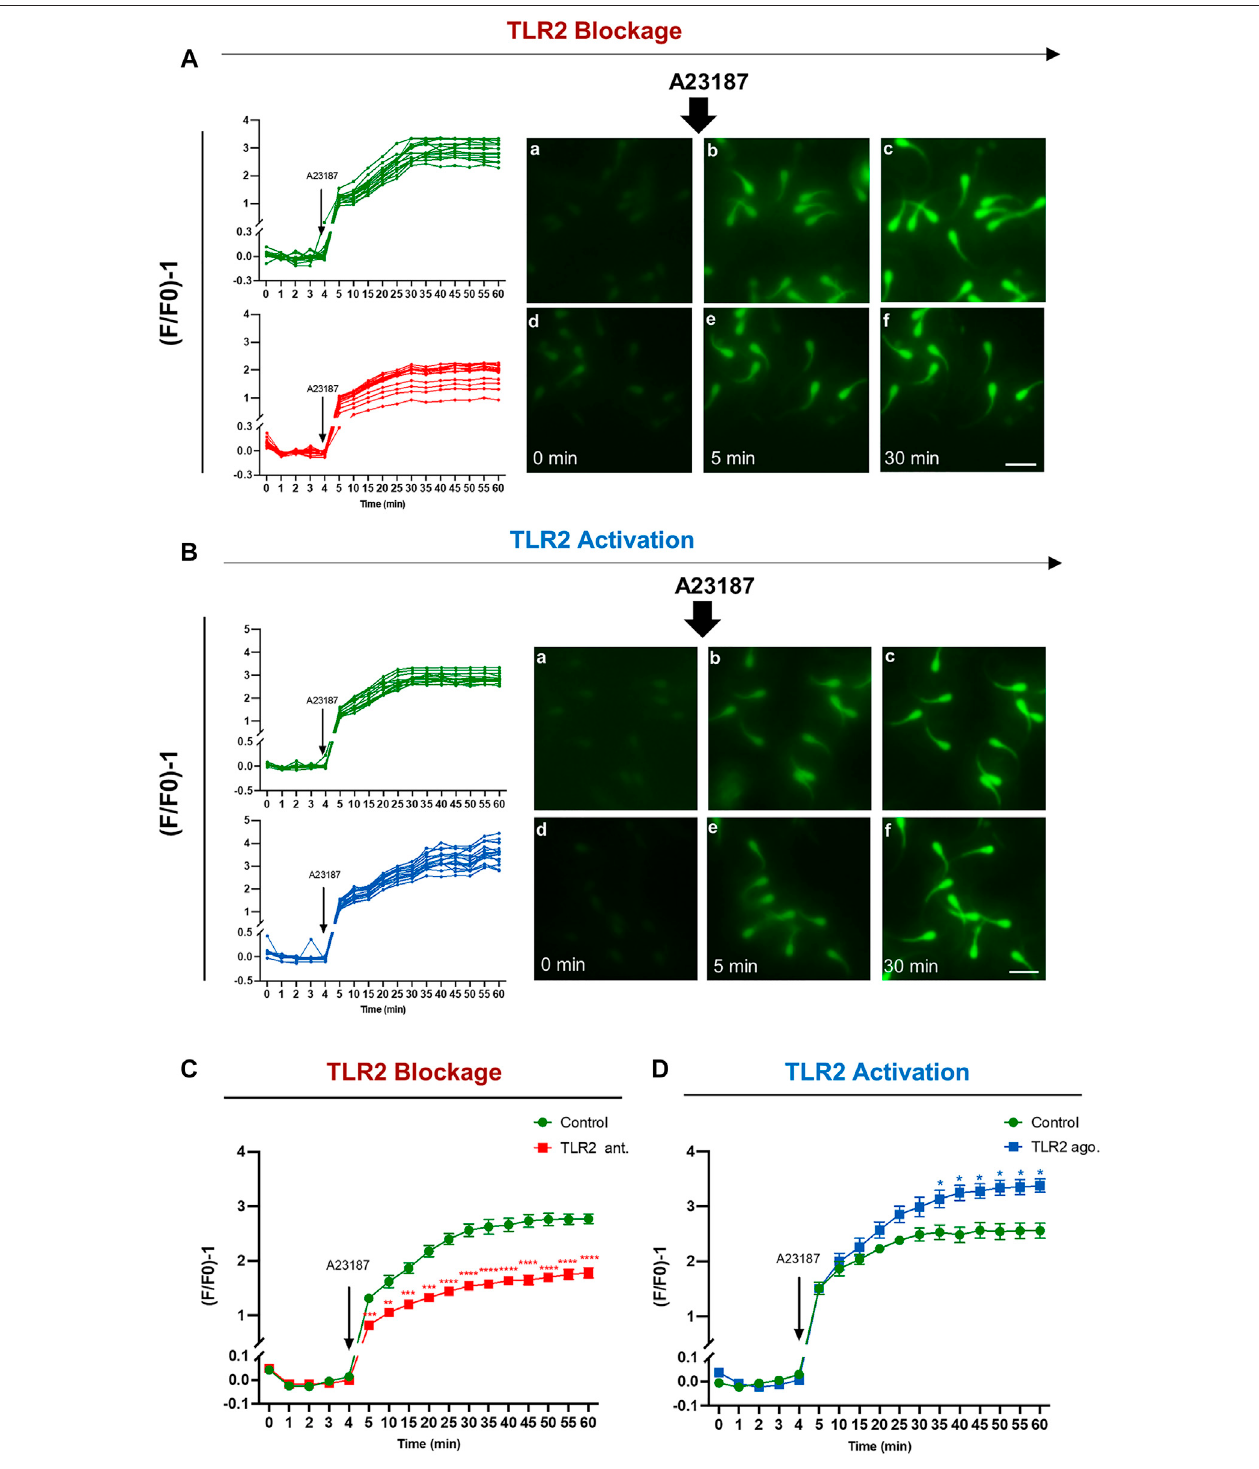
FIGURE 7 | TLR2 system manipulates the intracellular calcium uptake by bovine sperm. Swim-up sperm were pre-treated by TLR2 antagonist (100 µM) or TLR2 agonist (100 ng ml − 1 ) for 30 min, washed, and loaded with 5 µM Fluo-4 AM for 40 min at 38.5 ° C in the dark before adding calcium ionophore A23187 (1 µM as a fi nal concentration). The sperm fl uorescence was measured by the fl uorescence microscope. Images were captured every 5 min for a total of 1 h, with A23187 added after the initial fi ve readings (every 1 min). The images were analyzed using BZ-X800 Analyzer and each sperm head was selected as the region of interest. Data were normalized using the following equation (F/F0)-1. where F0 is the average of the fi rst fi ve readings before the addition of